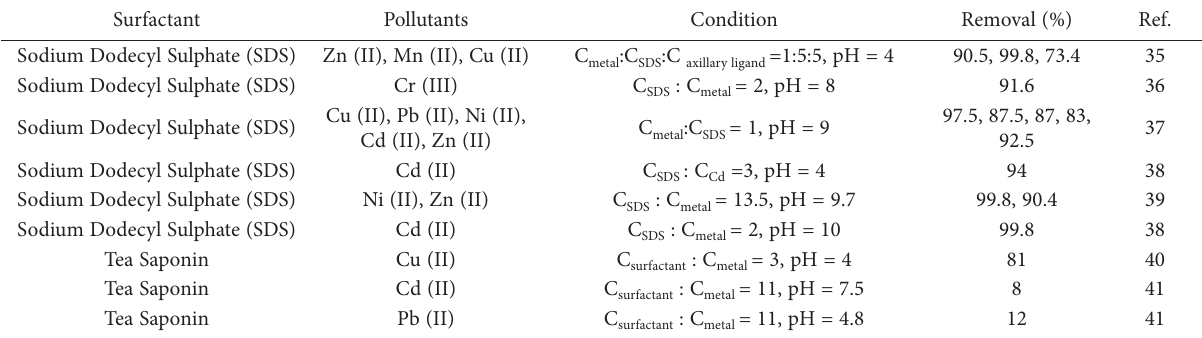
Table 5. Using sodium dodecyl sulfate and tea saponin surfactants in the process of ion flotation for removing heavy metal ions from water. Surfactant